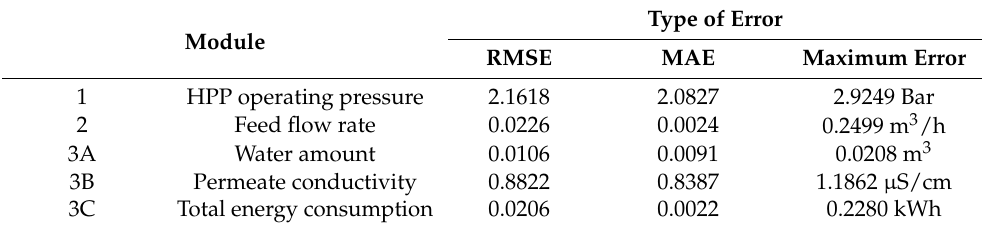
Table 7. Error checking through the test group of data (remaining 20% of data).